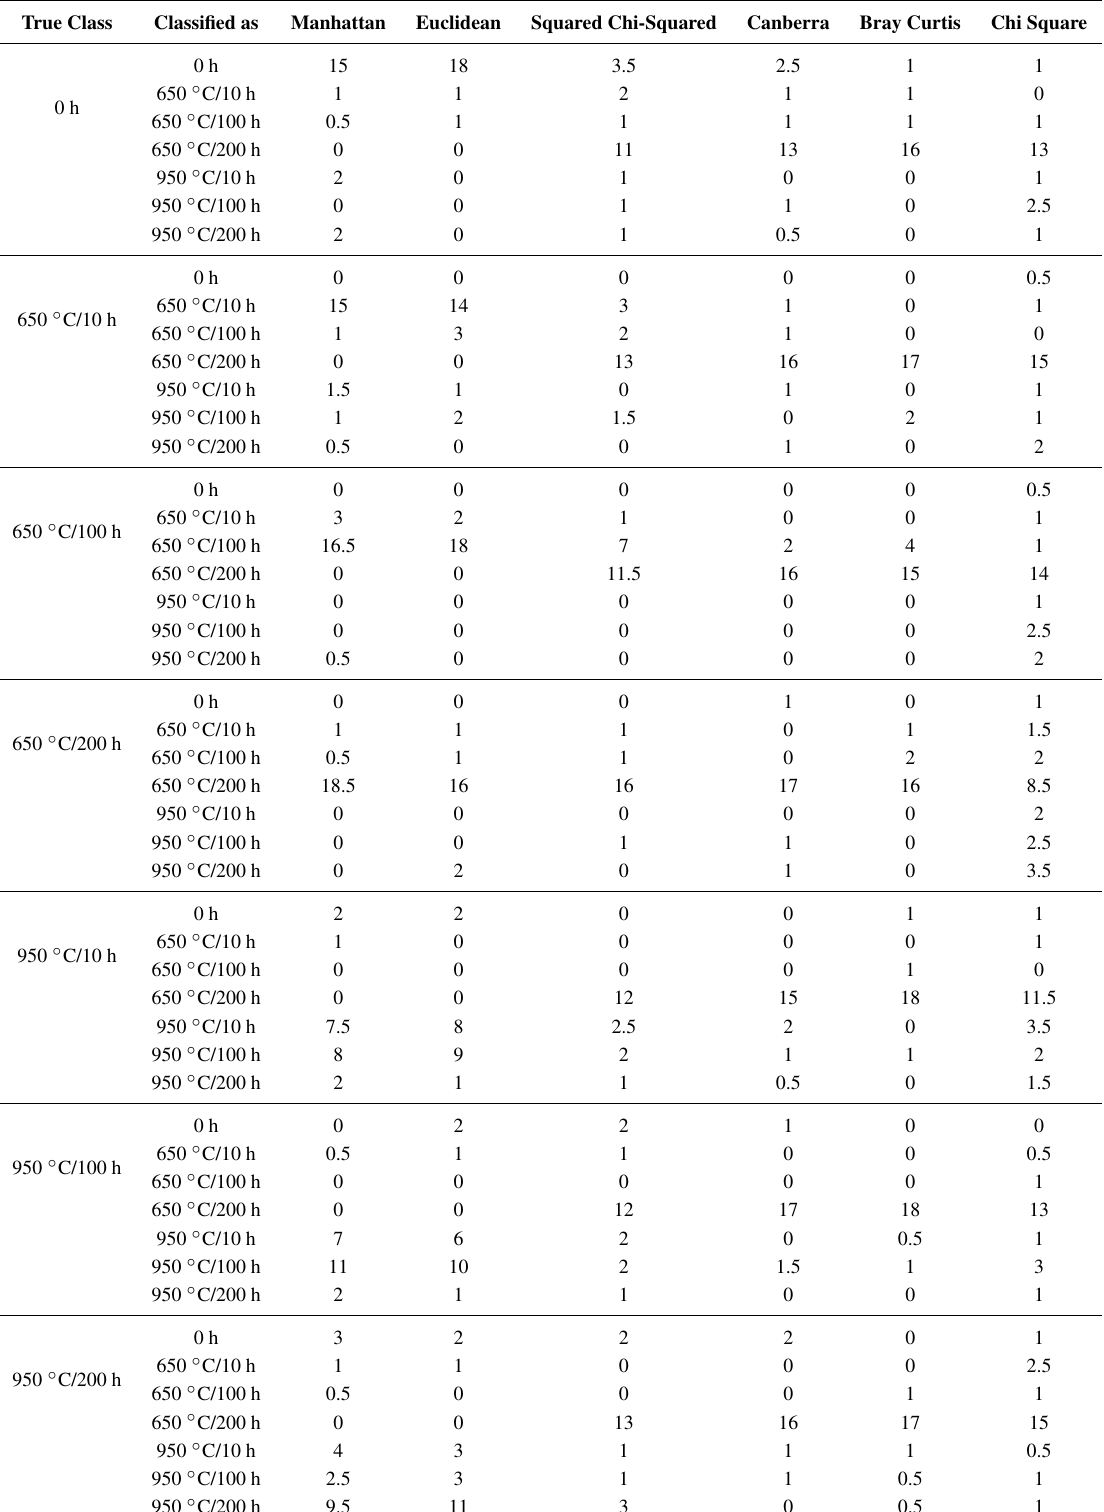
Table 15. Confusion matrix of the classification means for the 4-MHz frequency backscattered signals at 650 and 950 ◦